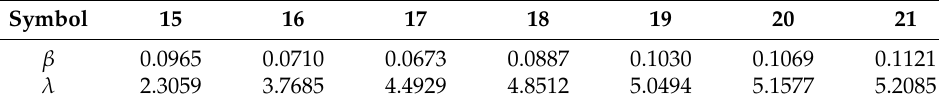
Table 4. Mean and standard deviation between 15 and 21